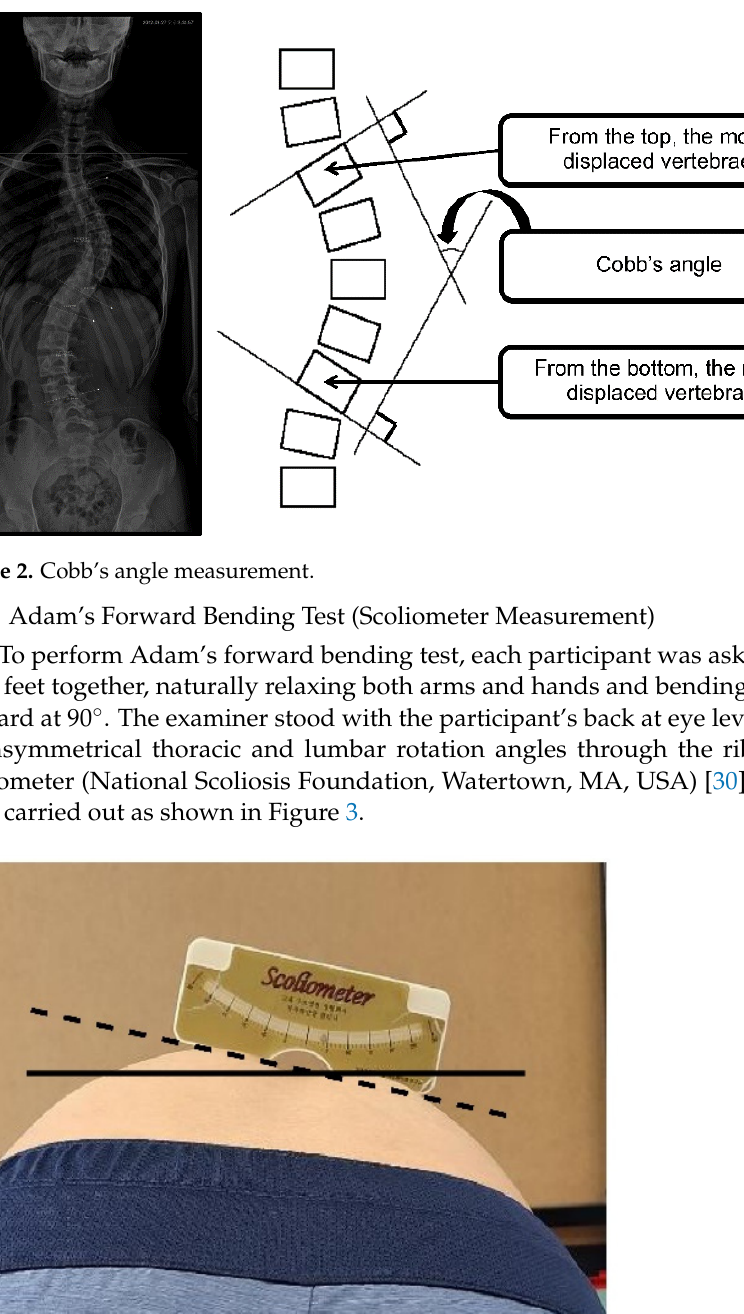
Figure 1. Inspection processes and procedures. G1, mild idiopathic scoliosis group with a Cobb’s